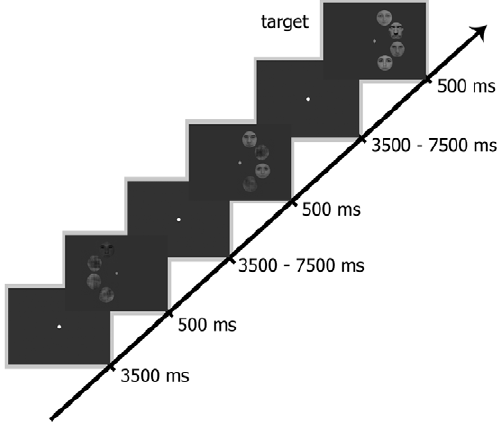
Figure 9. Procedures and example stimuli. Timeline depicts the stimuli of 1F and 2F1G conditions in the left and right visual hemifield, respectively as well as an example of a target trial (4F, right hemifield).